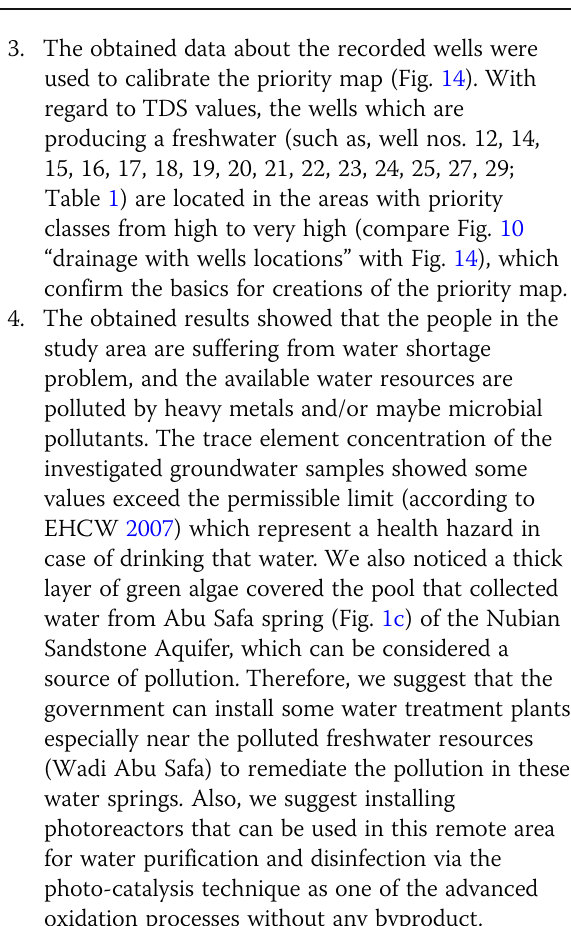
Fig. 14 Recommendation map clarifies the priority areas for future groundwater